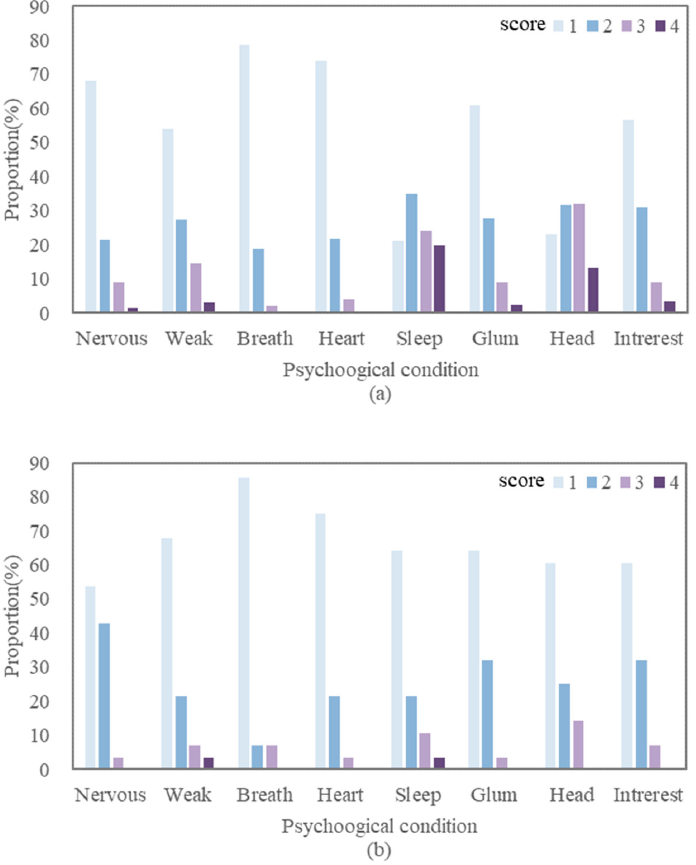
Figure 4. Distribution of the individual psychological state scores of ( a ) isolated and ( b ) free-moving participants.